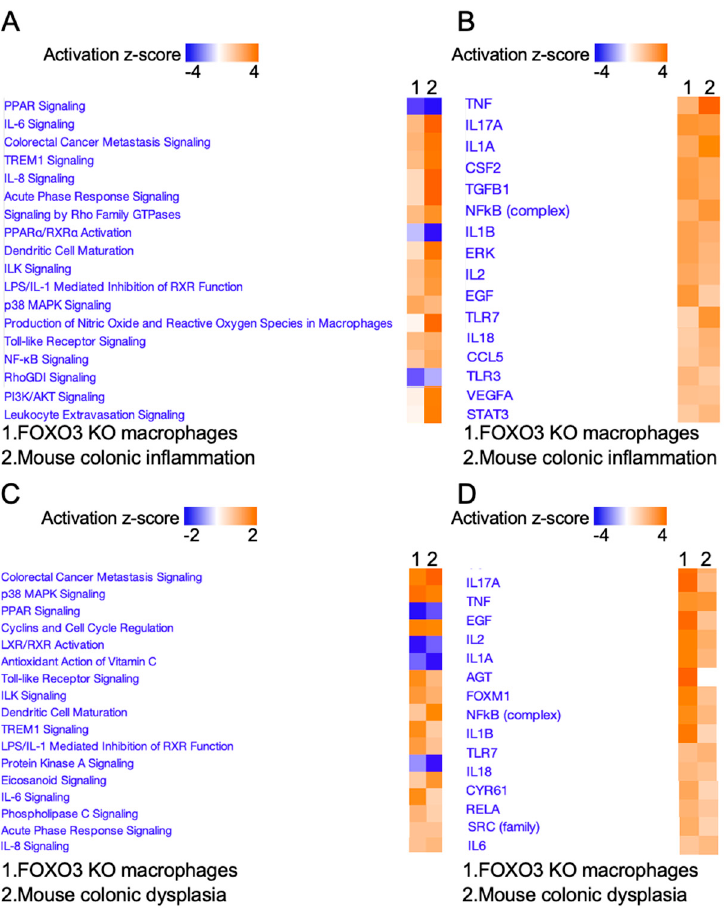
Figure 2. FOXO3 deficiency in macrophages links to mouse colonic inflammation and dysplasia. ( A , B ) Top canonical pathways and upstream regulators affected by FOXO3-deficient macrophages which are altered in mouse inflamed colonic tissue ( n = 3, GSE31106, p < 0.05, IPA). ( C , D ) Top